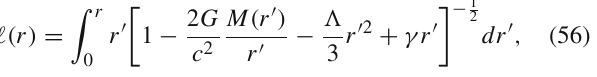
Fig. 3 Variation of the dimensionless mass μ as a function of the dimensionless radial coordinate η for a constant density star in dRGT massive gravity